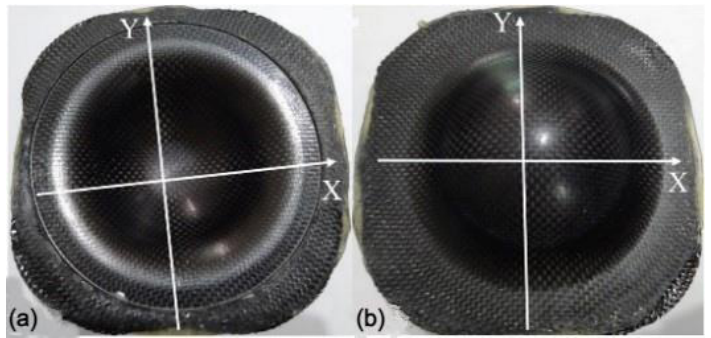
Figure 4. Deep drawing of composite-90 specimen: ( a ) front view, ( b ) back view.